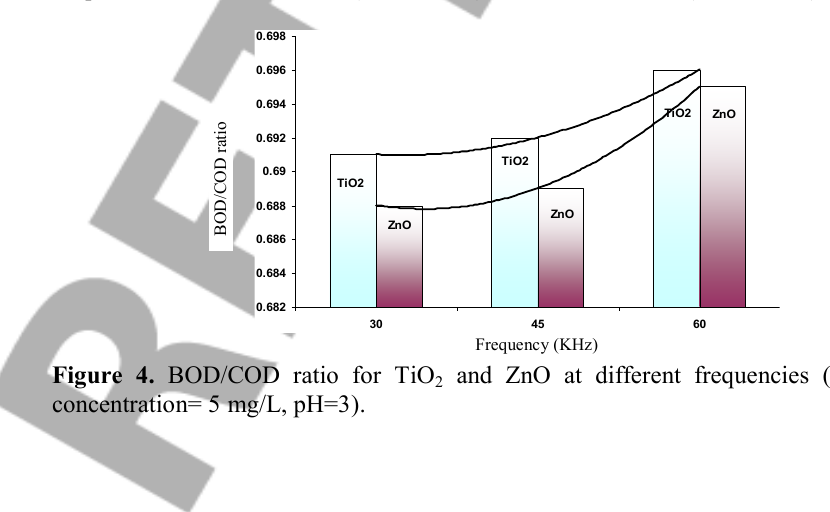
Figure 4. BOD/COD ratio for TiO concentration= 5 mg/L,